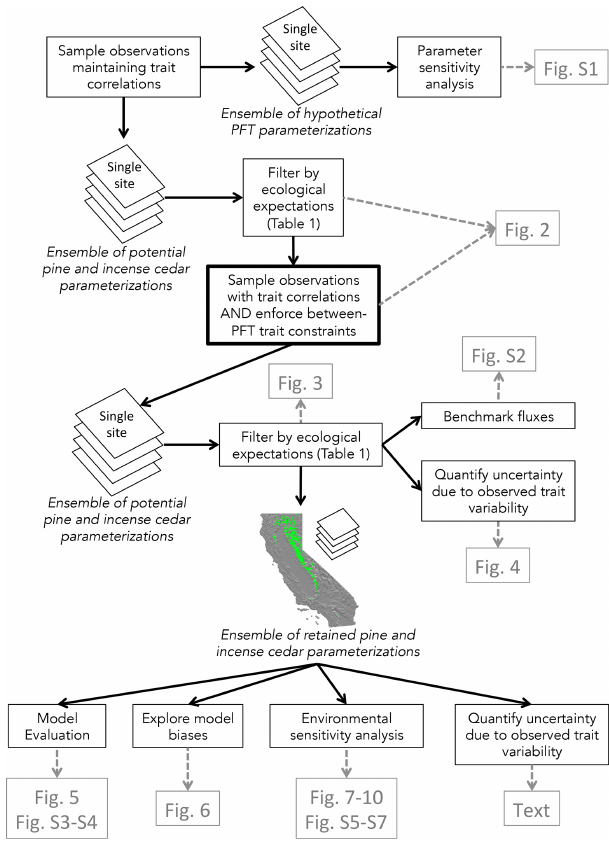
Figure 1. Overview of our workflow for developing and apply- ing PFT parameterizations. We suggest sampling with relative trait value constraints to create the initial ensemble of potential PFT pa- rameterizations. An initial sensitivity analysis may be necessary if applying the VDM in a new ecosystem. Ecological expectations are developed according to understanding of the climate and distur- bance controls on coexistence in that ecosystem. These expectations are used to filter the simulation outcome, thereby retaining PFT pa- rameterizations that conform to their intended ecological niches. The retained parameterizations are applied to a regional domain to evaluate model performance, model biases, and environmental con- trols, which can indicate potential for improvements to PFT def- initions or forcing data, or representation of processes within the model. Retaining an ensemble of parameterizations allows for quan- tification of uncertainty in simulated outcomes due to variability in trait